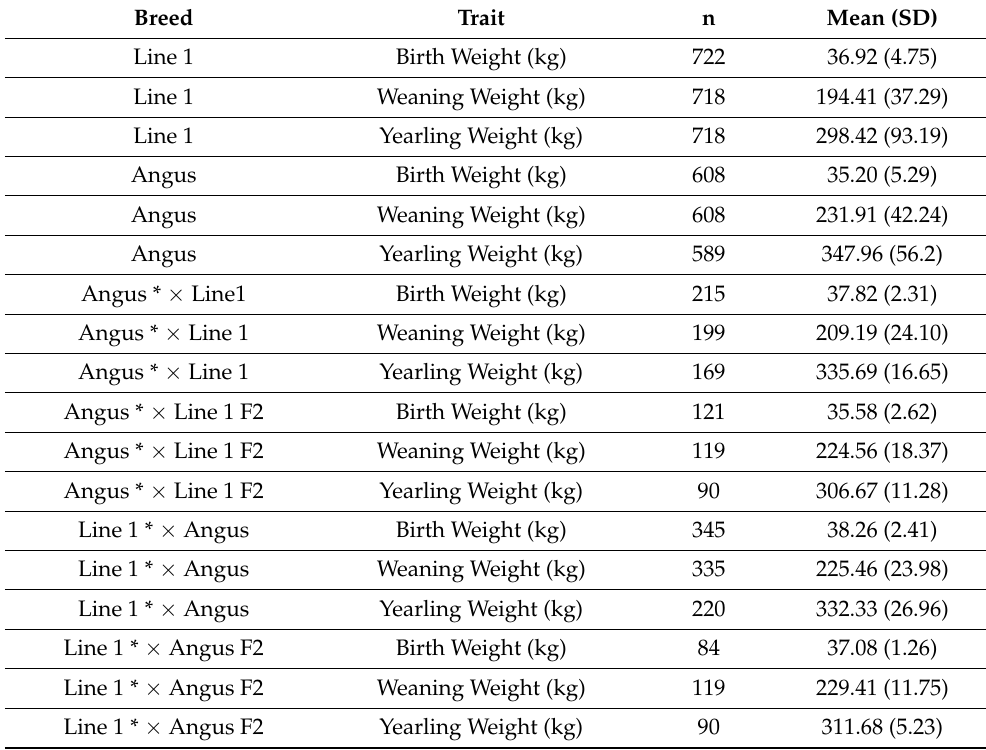
Table 1. Summary statistics of growth phenotypes.